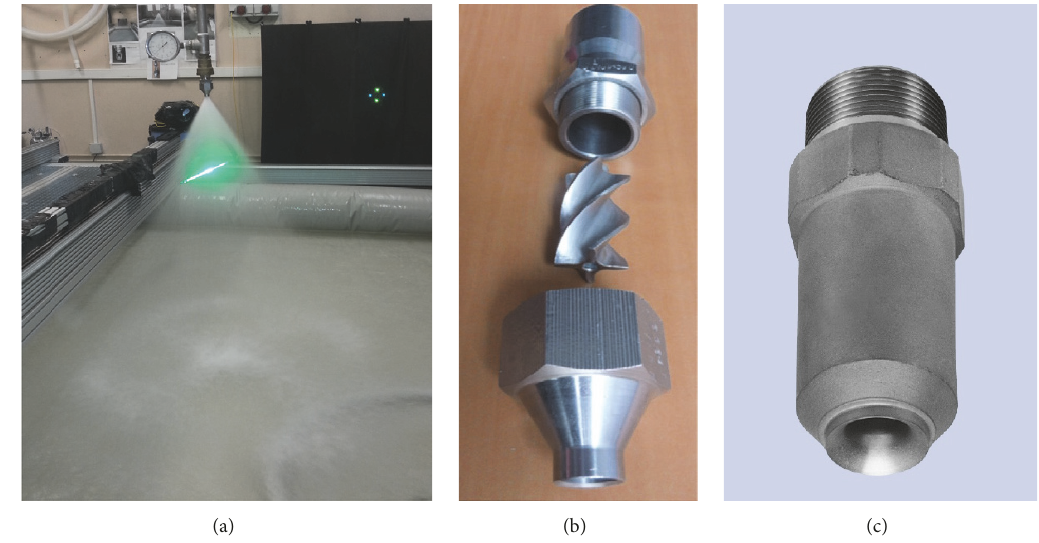
Figure 2: A single full cone spray (a) with VVER nozzle (b) and a full come designed by Lechler (c) [3, 23].